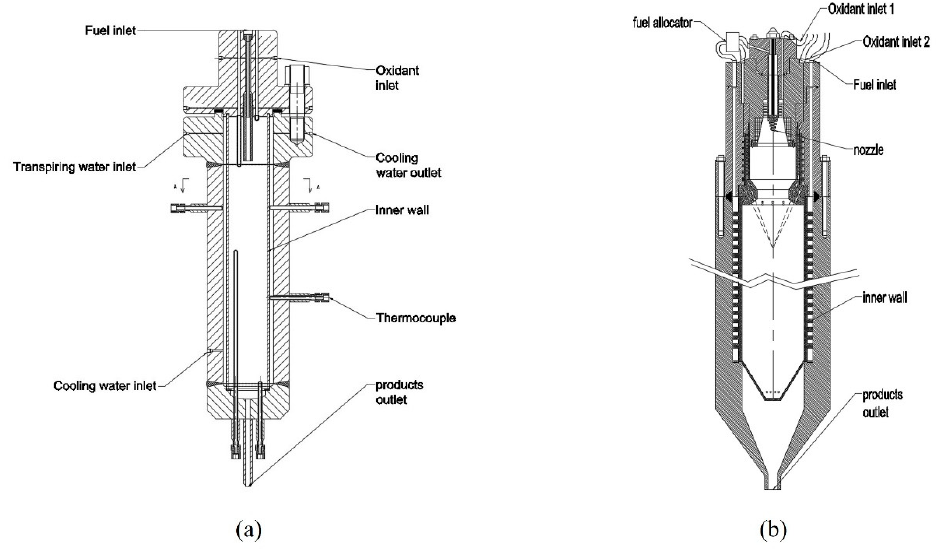
ffi ciency HFR from Xi’ an Jiaotong University ( a ) first version; ( b ) second Figure 5. High-efficiency HFR from Xi’ an Jiaotong University (a) first version; (b) second version Figure 5. High-e